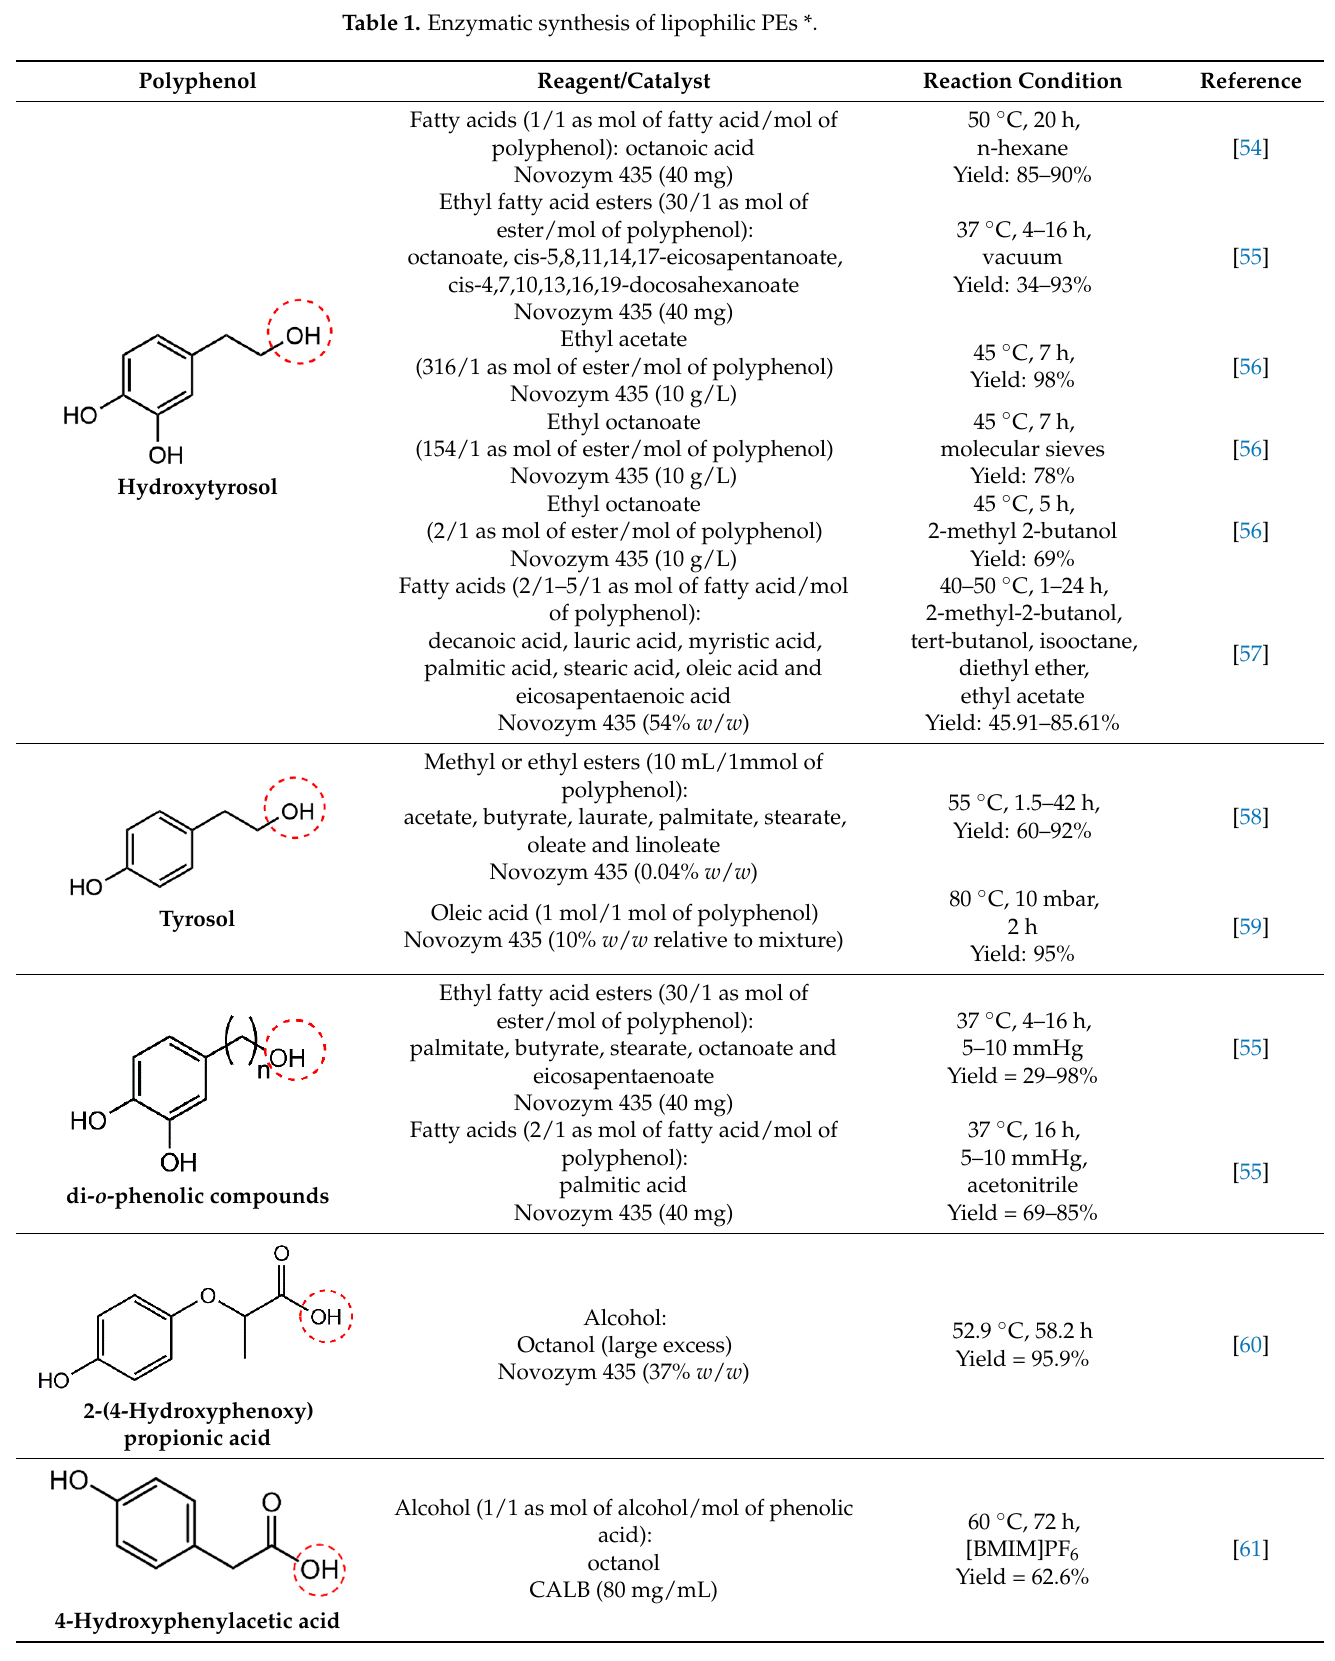
Table 1. Enzymatic synthesis of lipophilic PEs*.